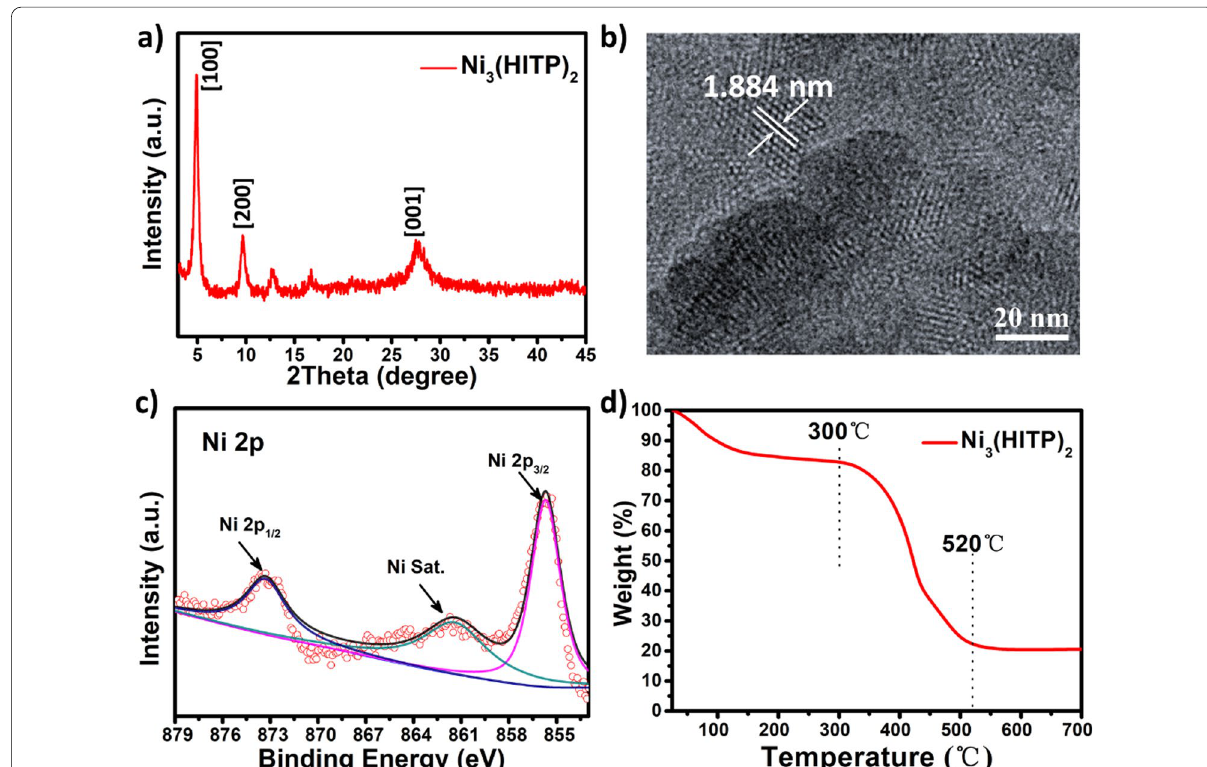
Fig. 1 Characterization of the Ni 3 (HITP) 2 film. a XRD pattern, b TEM micrograph; c XPS spectra of Ni 2p, and d thermogravimetric curve of the Ni 3 (HITP)